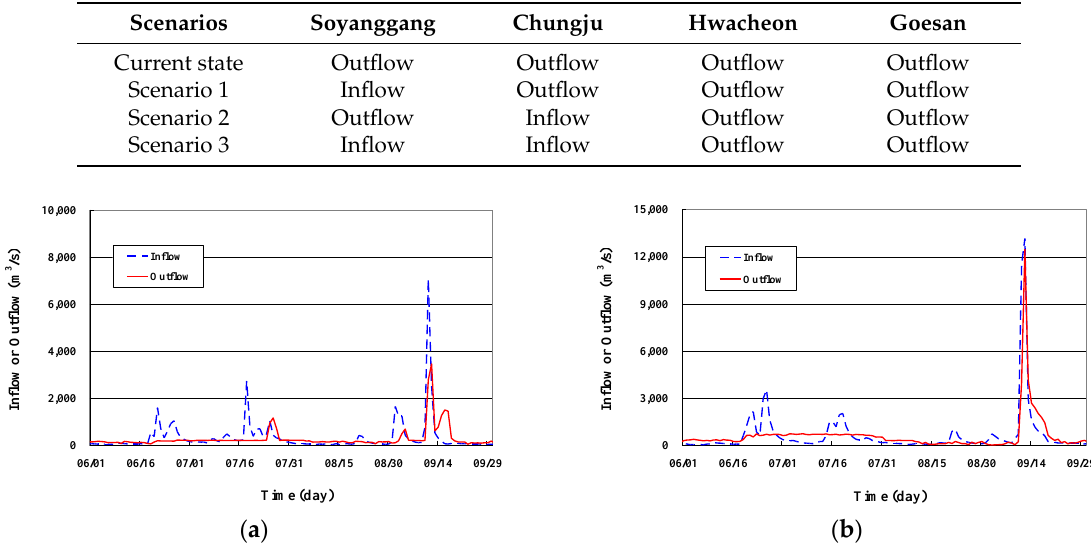
Figure 2. Inflow and Outflow in 1990. ( a ) Soyanggang Dam; ( b ) Chungju Dam.